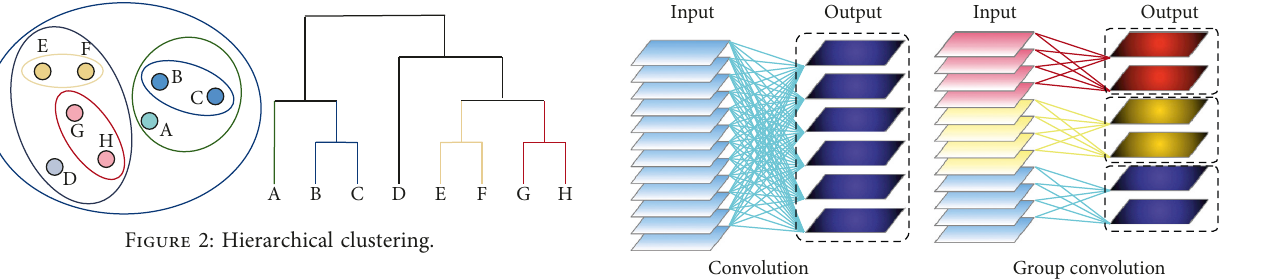
Figure 3: Normal convolution and group